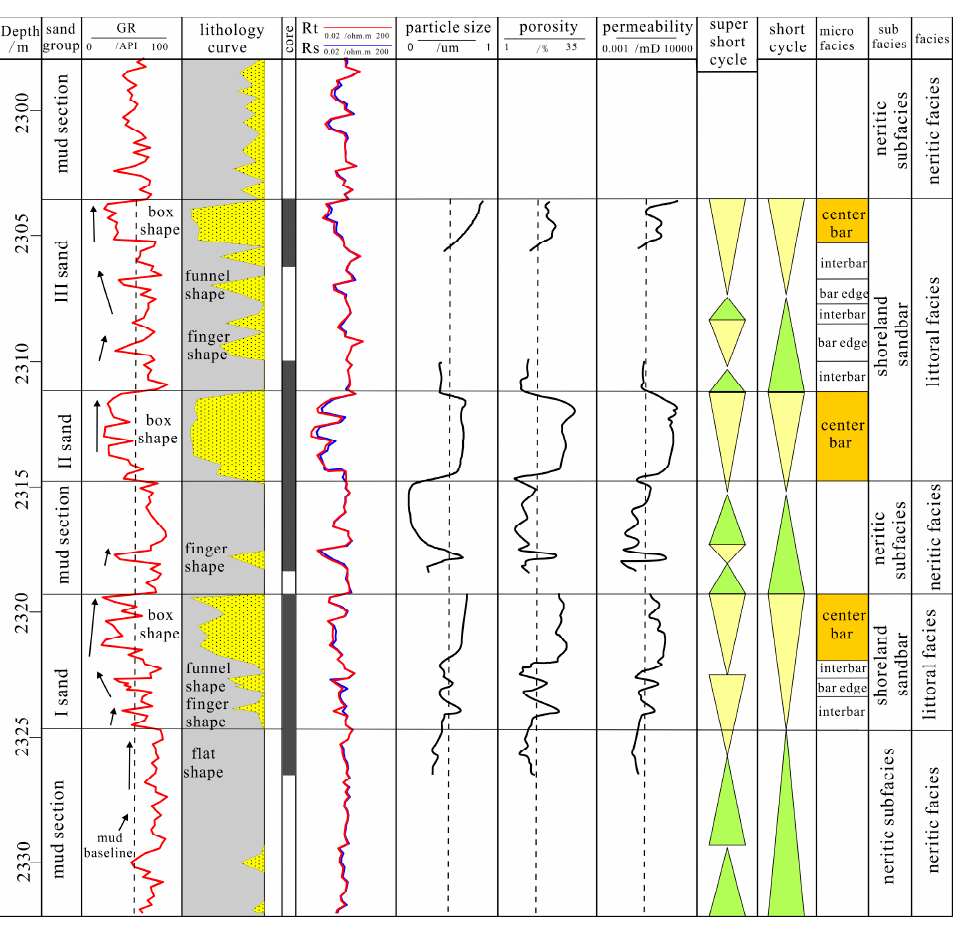
Figure 5. Logging motifs characteristic, reservoir physical property, sedimentary cycle and micro- facies composition of B member sandbar reservoir (for the stratigraphic position of B member see Figure 2).